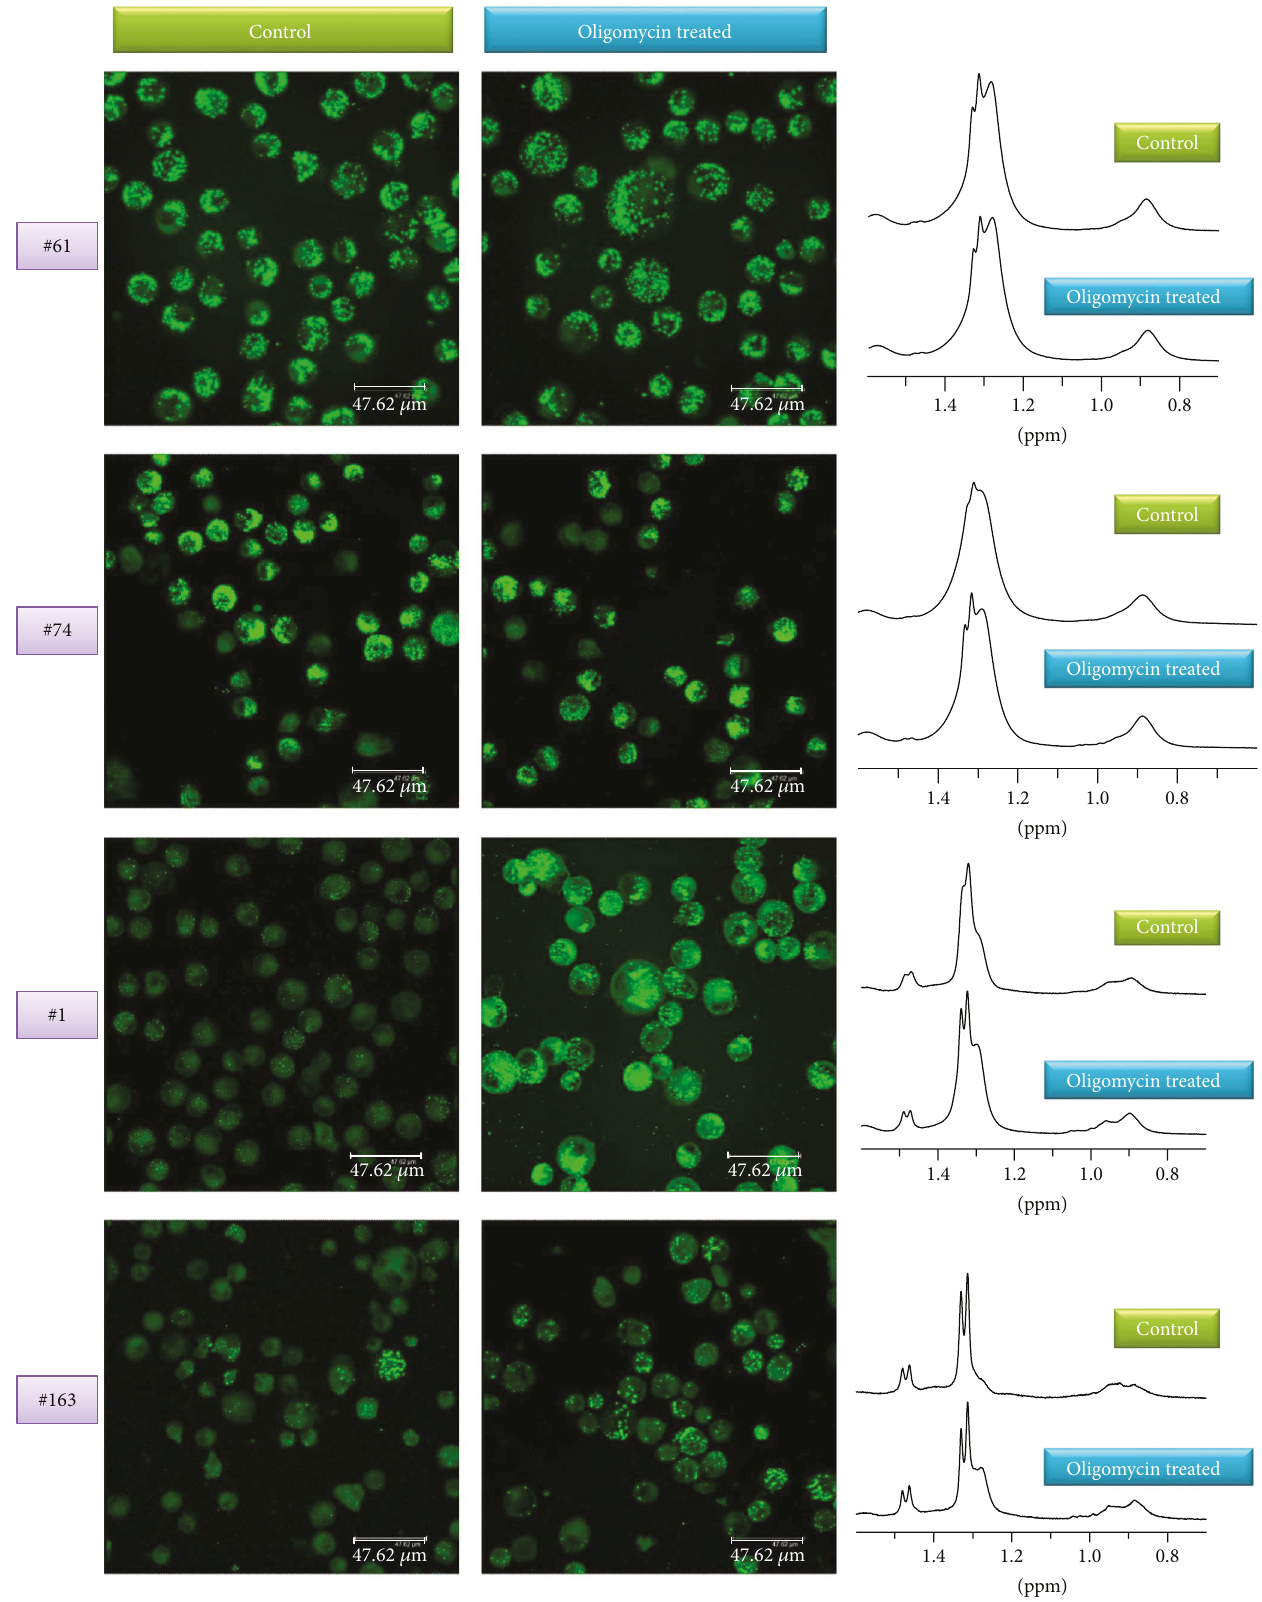
Figure 5: Analysis of the e ff ects induced by oligomycin treatment. Confocal microscopy images and ML signal region from 1D 1H MR spectra of control and oligomycin-treated GSC lines #61, #74, #1, and